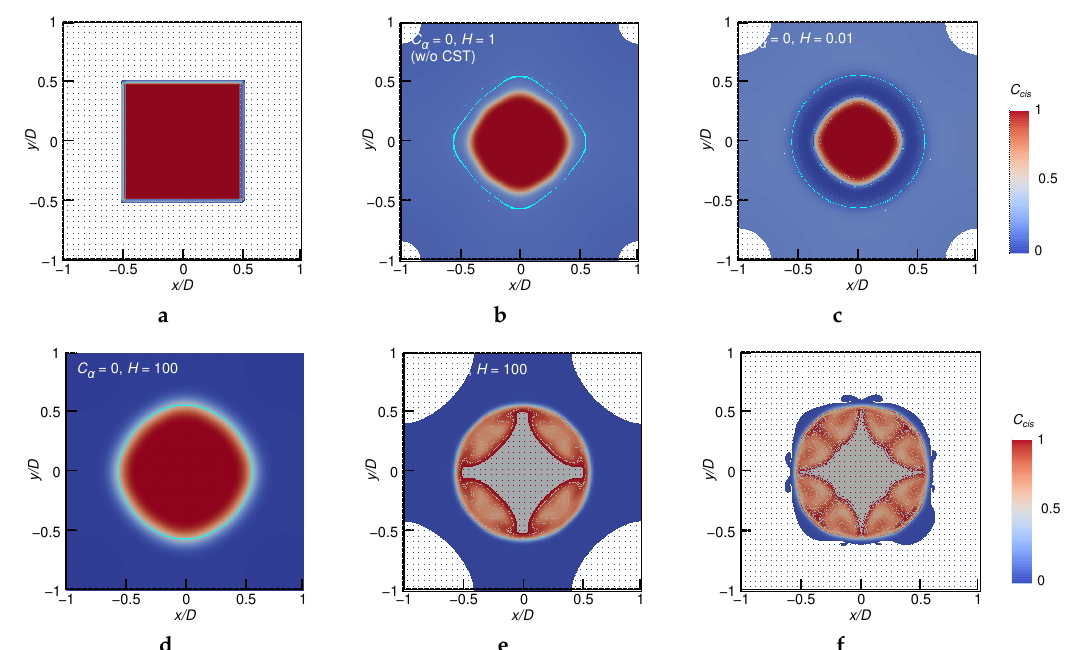
Figure A2. Contour of C cis distribution obtained at 0.2 s (except for a ) after the release of a free square droplet, for different values of H and C α and with/without the CST model. ( a ) Initial state of all cases at 0 s. ( b ) C α = 0, H = 1, without the CST method. ( c ) C α = 0, H = 0.01. ( d ) C α = 0, H = 100.